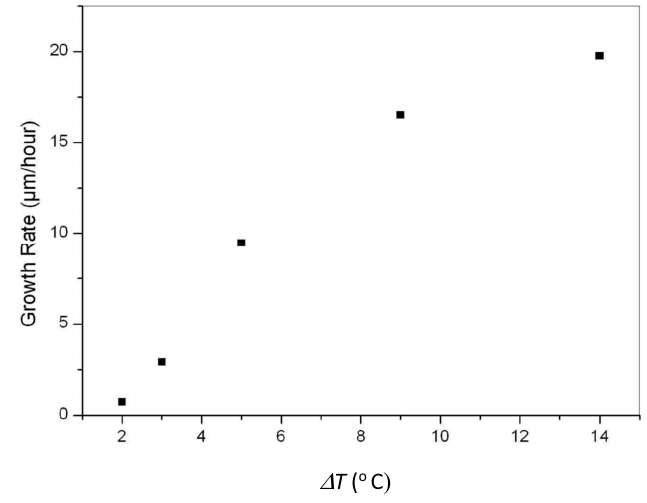
Figure 2. Nd:YAB crystal growth rate on the rhombic face seed crystal versus temperature below saturation Δ T (°C) .